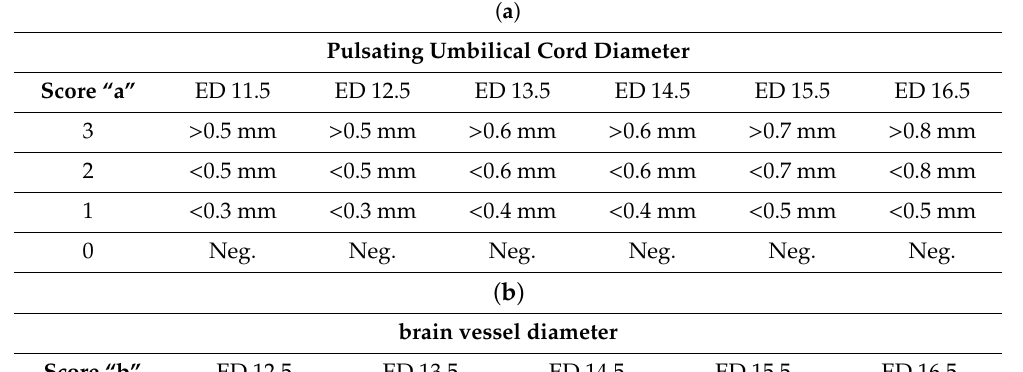
Table 1. Scoring sheet for characterization of blood flow activity in the umbilical cord and the fetal brain. ( a